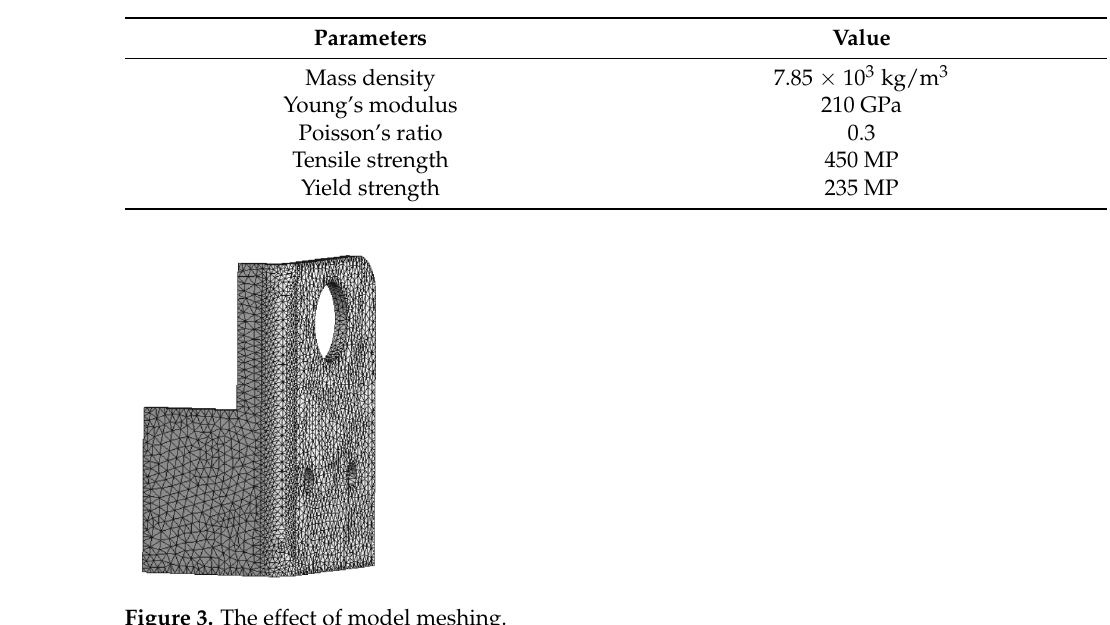
Table 1. Q235 material properties.